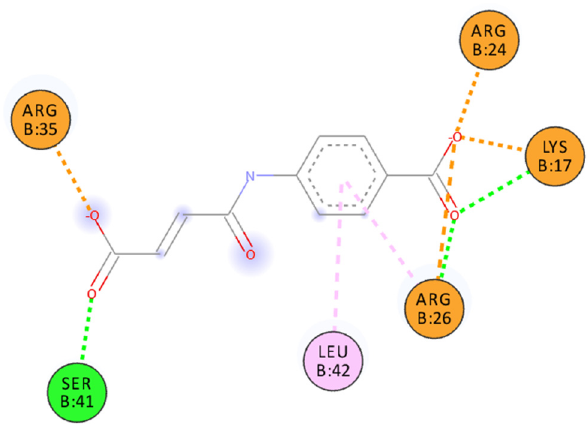
Figure 3. Binding pose of 7a docked to IL–15R α . Interactions color codes: green—hydrogen bond, light pink—hydrophobic interaction, orange—charged interaction. Table 3. Selected ADME properties of the new compounds (unit, range of descriptors values for 95% of known drugs). Values out of range are highlighted in